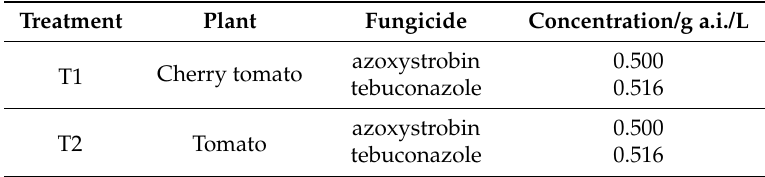
Table 1. Spray conditions for the two treatments during